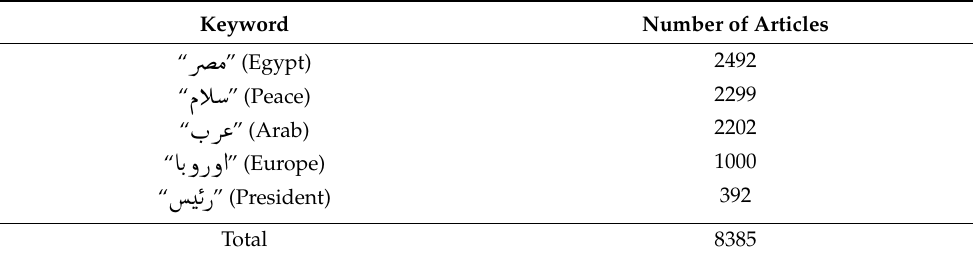
Table 2. Keywords used to build the